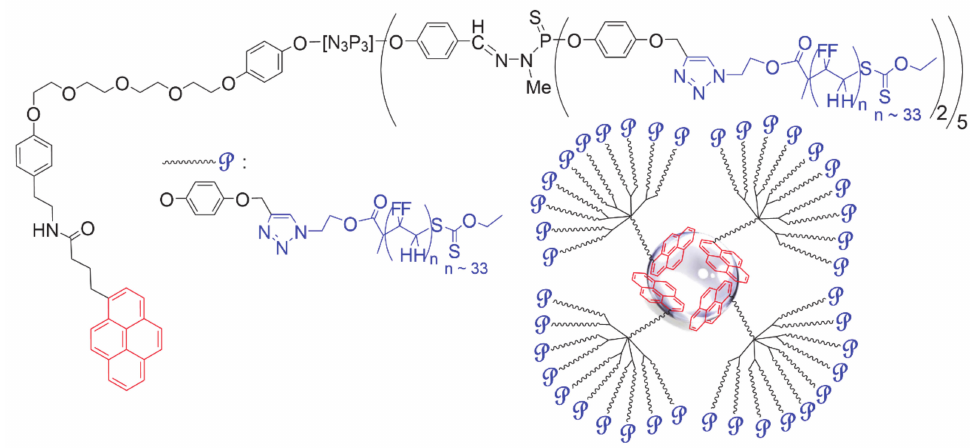
Figure 4. Chemical structure of a dendron bearing vinylidene fluoride polymers on the surface, and used for coating cobalt nanoparticles covered by